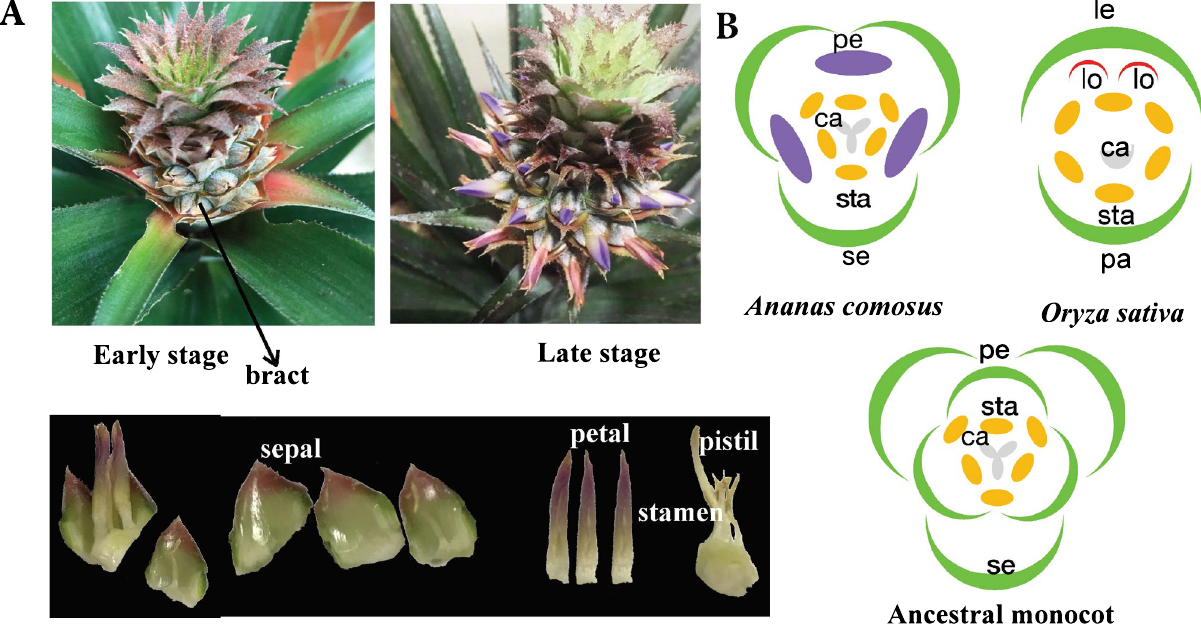
Figure 1. Floral organs of pineapple and floral diagrams of pineapple, rice, and the ancestral monocot. ( A ) Inflorescence of pineapple. Dense pineapple flowers are arranged in a spiral at the periphery of the spadix rachis. Each flower comprises sepals, petals, stamens, and pistils and is protected by one thick bract. ( B ) Floral diagrams of pineapple, rice, and the proposed ancestral monocot. Individual pineapple flowers are trimerous with three sepals (green) and petals (purple) in the two outer whorls, six stamens arranged in two whorls with three organs in each, and one pistil with three fused carpels in the center. In rice, there are two outer perianth organs (green, adaxial palea and abaxial lemma); two lodicules (red) internal to the lemma, corresponding to petals in non-grasses; six stamens in one whorl; and a single carpel. The floral structure of the ancestral monocot is similar to that of pineapple, except for the two outer whorls of perianth organs. se sepal, pe petal, sta stamen, pa palea, le lemma, lo lodicule, ca